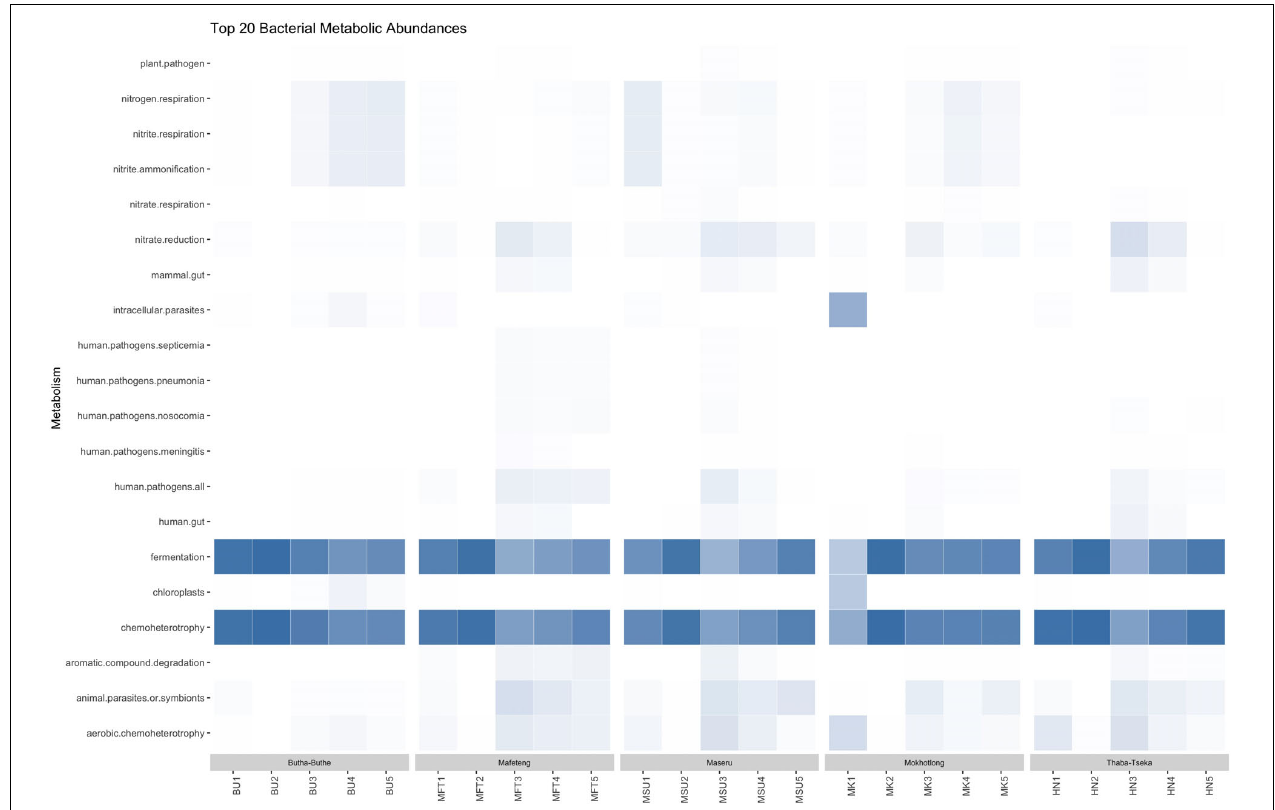
FIGURE 5 | Heatmap of functional diversity of all Sesotho bacterial samples during the fermentation process.